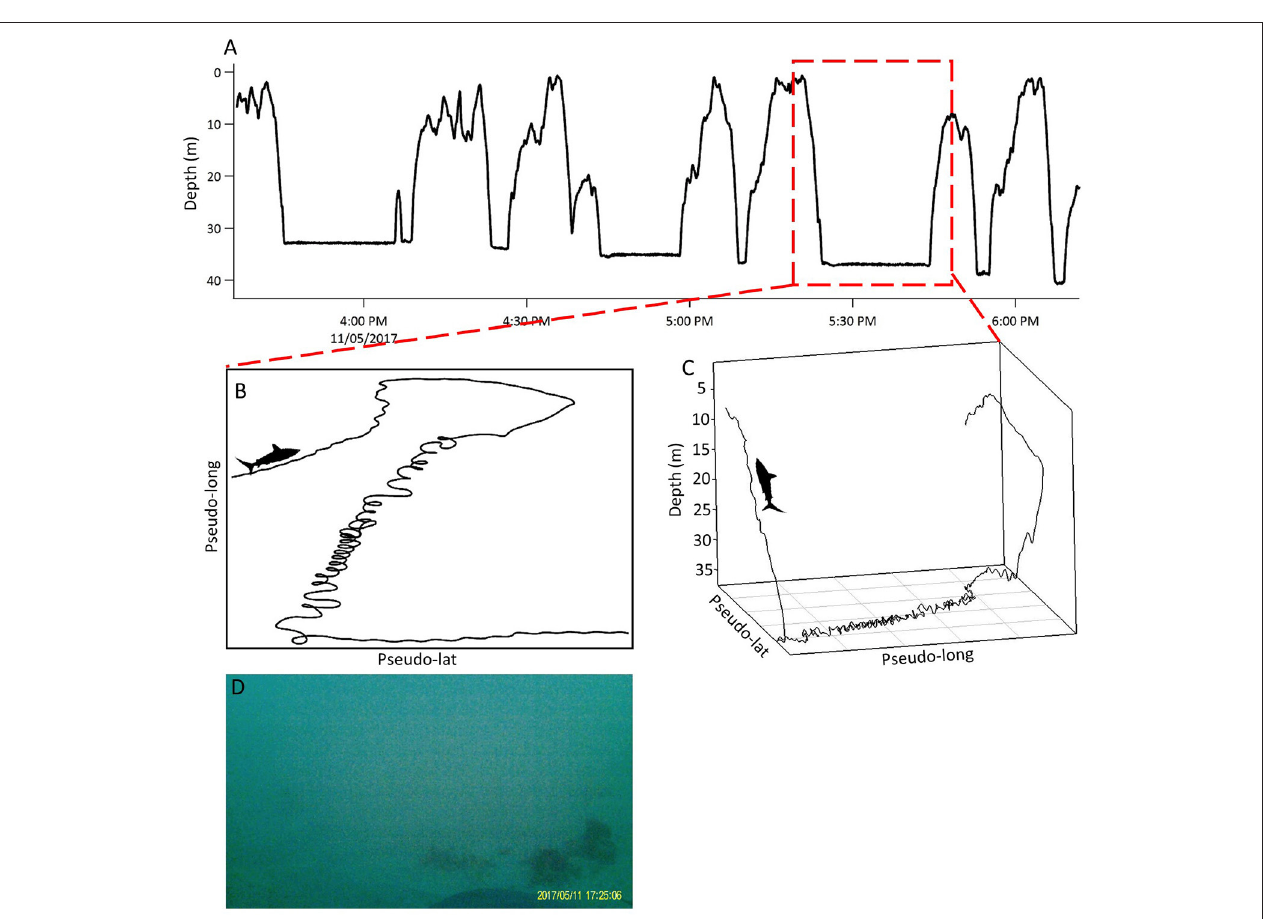
FIGURE 4 | U-shaped dives and looping behavior in Shark 1. (A) Depth record displaying U-shaped dives in the late afternoon and dusk. Red square denotes 15min period of looping behavior displayed in (C) and (D) . (B) Pseudo-track. (C) 3D track. (D) Screenshot of Shark 1 swimming at the seabed on the bottom phase of a U-shaped dive. Shark silhouette indicates direction of travel by shark. Note that the x and y -axes in (B) and (C) represent arbitrary units of latitude and longitude as they were created by dead-reckoning using magnetometer and accelerometer data assuming a constant